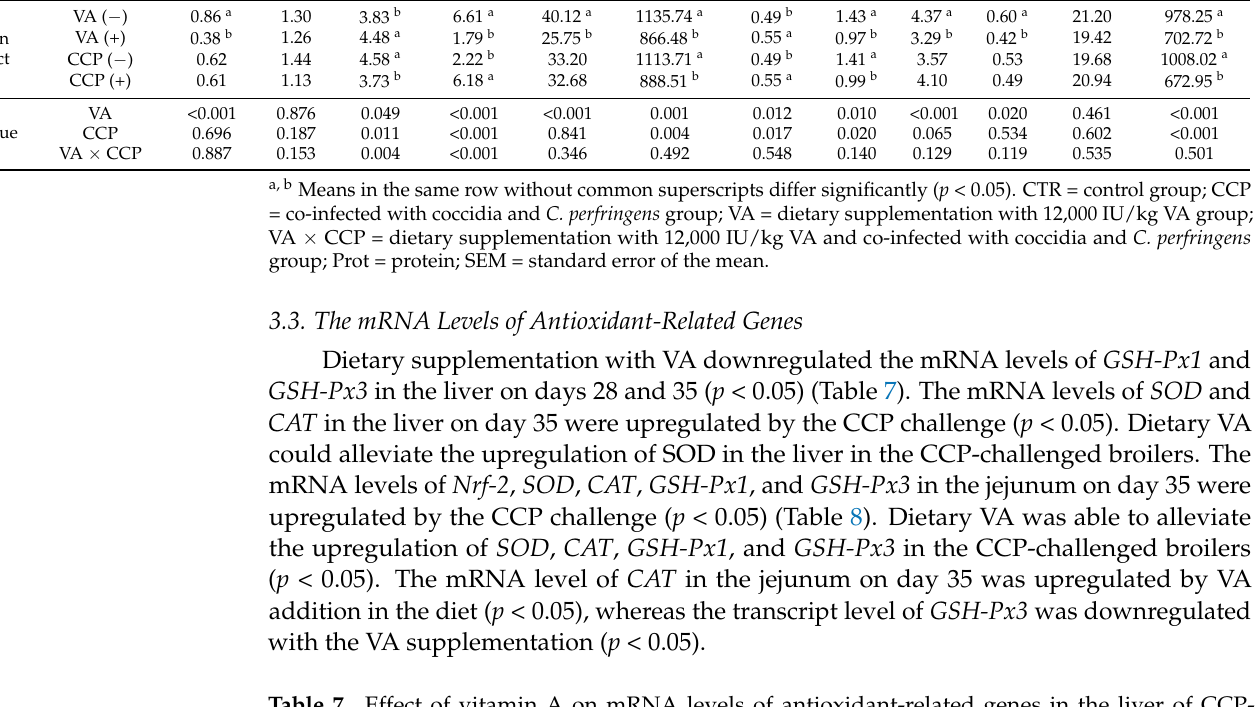
Table 7. Effect of vitamin A on mRNA levels of antioxidant-related genes in the liver of CCP- challenged